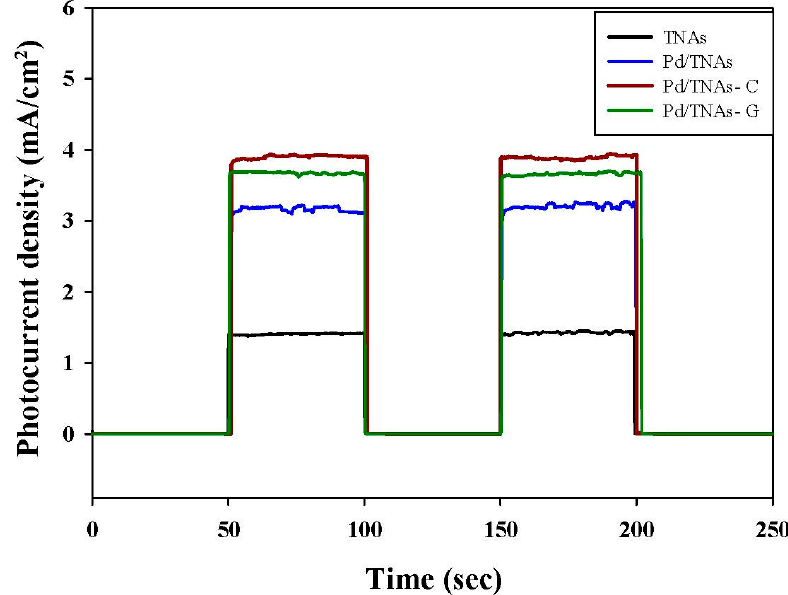
Figure 5. I-t graph of each material by switching lamp test under 100 W Hg lamp illuminations.